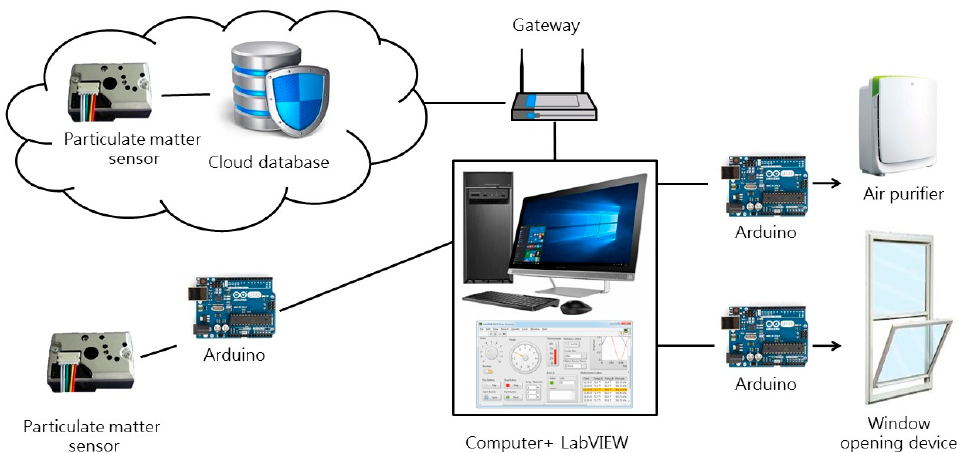
Figure 8. Block diagram of indoor air quality control system.